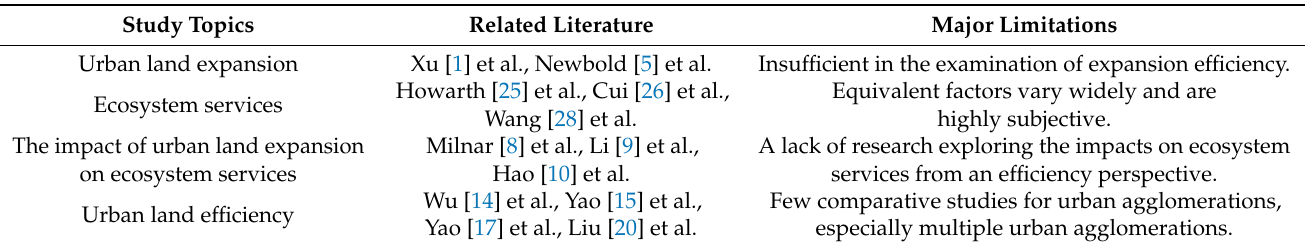
Table 1. Major limitations of related